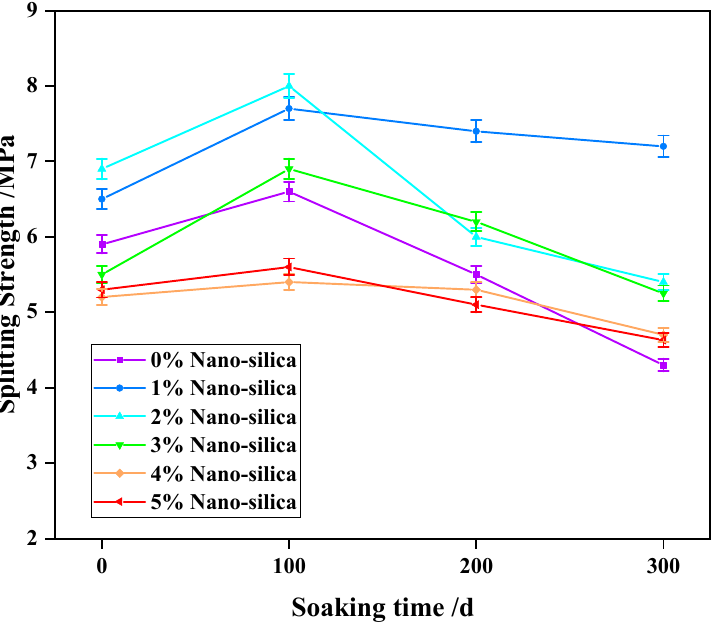
Figure 8. The time-dependent splitting strength of HPC specimens subject to sulfate attack. With respect to the compressive strength, the pozzolanic activity and filling effect of NS can promote the strength of cement-based materials [21,26,41,45]. Therefore, the qual- ity of HPC specimens can be guaranteed under the conditions of sulfate attack. On the contrary, with the addition of too much powder, the nanoparticles in the cement matrix are difficult to evenly disperse, and the water consumption in the hydration reaction pro- cess weakens the working performance of concrete, resulting in an increase in the number of micro cracks and weak areas of concrete [7,46]. Therefore, it is difficult to guarantee the quality of concrete test block under sulfate attack. Meanwhile, for the splitting strength, the dispersed NS in HPC can provide a large number of attachment points for the cement hydration crystallization in the concrete, thus improving the corrosion resistance, and further improving the splitting strength of con- crete [20,27,47]. However, too much silica powder will easily induce the polymerization of HPC, making the nano molecules difficult to evenly disperse, and leading to the in- crease of micro cracks and weak areas of concrete, such that the splitting strength of con- crete decreases. 3.4. T 2 spectrum and Pore Size Distribution The T 2 spectrum detected by NMR can transform and judge the cumulative evolution law of HPC in response to sulfate erosion. As shown in Figure 9, the overall trend of T 2 spectrums are bimodal curves with major and minor amplitude peaks. The major peaks are mainly distributed in the micropores range (<10 ms) and the minor peaks are usually in the mesopores range (10–100 ms), indicating that the porosity of HPC specimens is mainly micro- and meso-pores. Sulfate erosion obviously promotes the porosity evolution of the unmodified HPC specimen, which initially increases the number of micropores, and then affects the meso- and macro-pores with increasing soaking time.